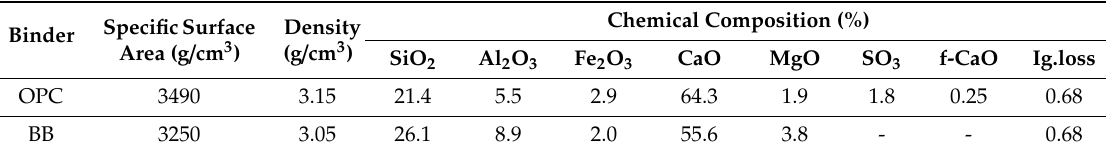
Table 3. Binding materials properties.